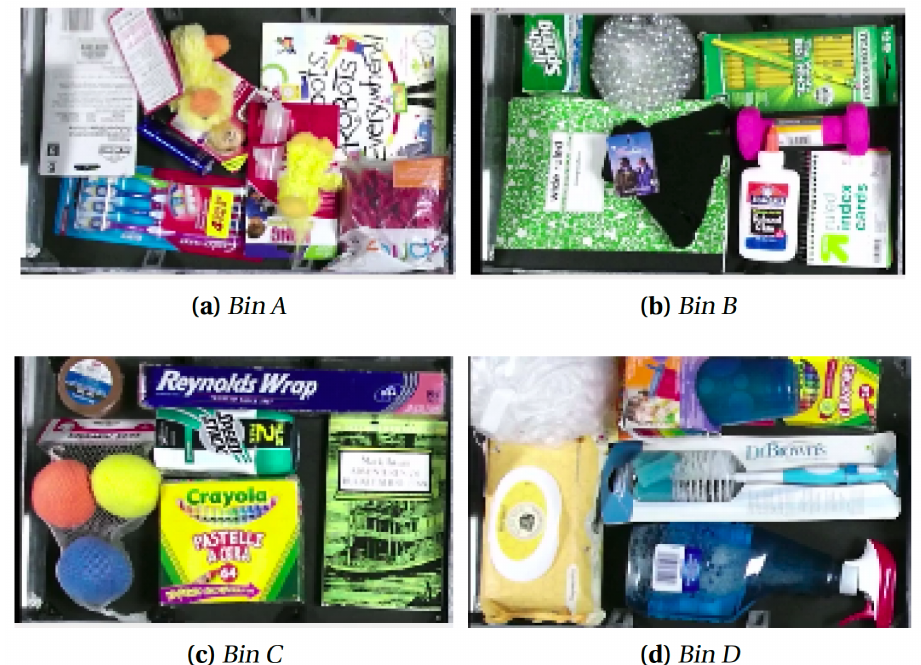
Figure 20. Initial setup for Test